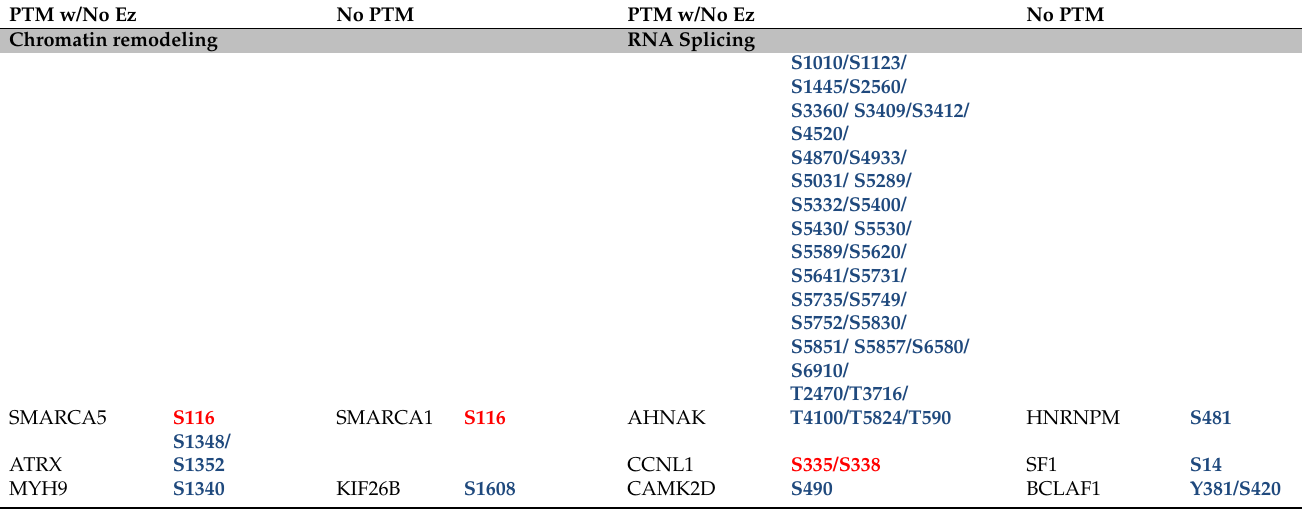
Table 2. Substrates and regulated phosphosites not described before (No PTM) or described with no kinase-associated (PTM w/No Ez) following iPTMNet analysis. Phosphosites with increased phosphorylation are in red and those with decreased phosphorylation are in blue. Gene symbols and the position of phosphosite in the proteins are shown. They are grouped by biological